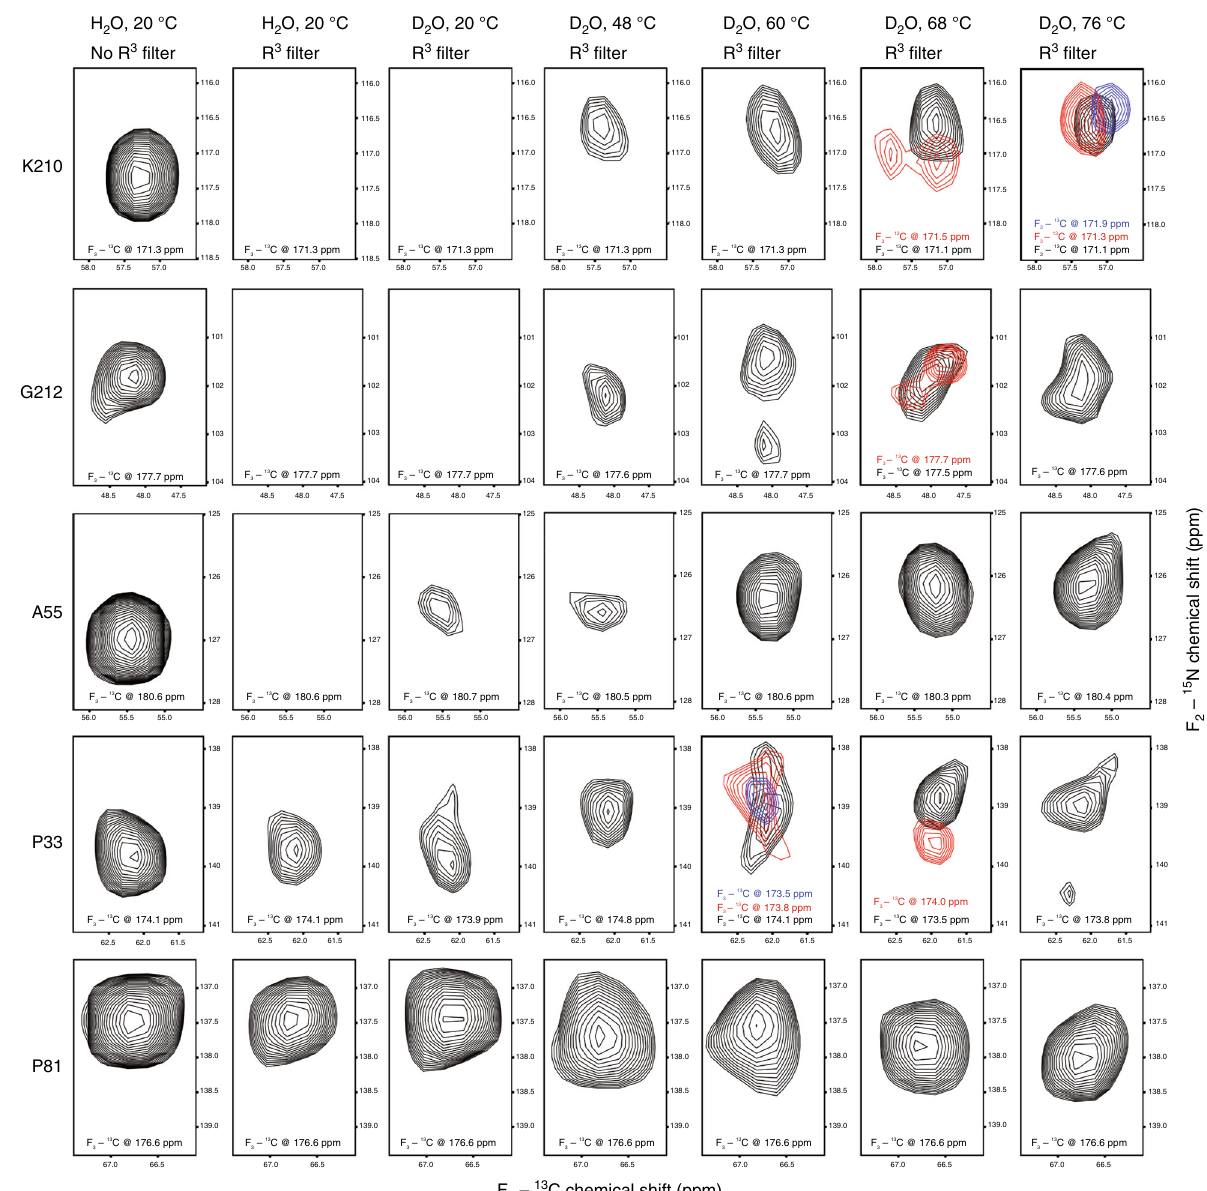
Fig. 4 Progression of H/D exchange in 3D R 3 -CANCO spectra. 2D planes from selected regions of the 3D R 3 -CANCO spectra illustrate the effect of R 3 fi lter and the H/D exchange as a function of incubation temperature on spectral intensities for selected residues: K210 and G212 (TM region of helix G), A55 (extracellular end of helix B), P33 (A-B loop), P81 (TM region of helix C). Splitting of the peaks (red and blue) indicate multiple local conformations resulting from the heating/cooling cycle. These conformations are however similar based on the small chemical shift differences. The fi rst contour is at 5 times root-mean-square of the noise. Buffer conditions (H 2 O or D 2 O), incubation temperatures, and R 3 fi lter conditions are indicated in the top row. All spectra were collected on sample